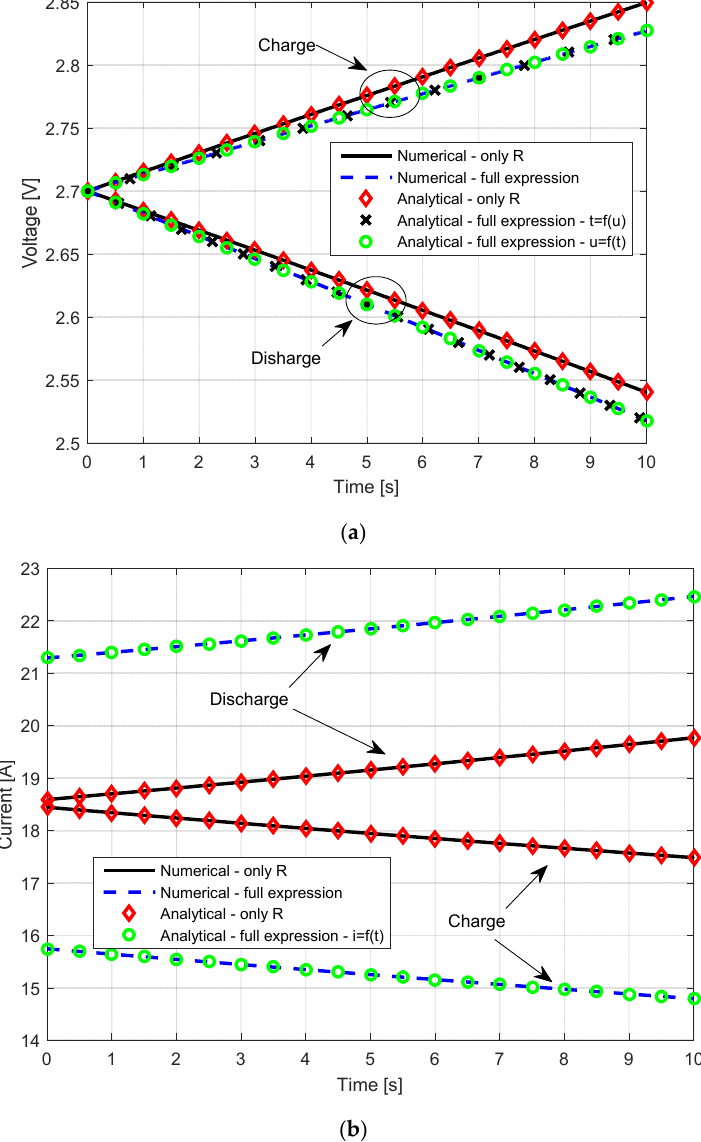
Figure 4. Characteristics of the SC at constant power determined using different methods during both charging and discharging processes ( R b = 1 Ω , P = 50 W, and C = 1200 F, and R = 0.58 m Ω ): ( a ) voltage versus time; ( b ) current versus time.